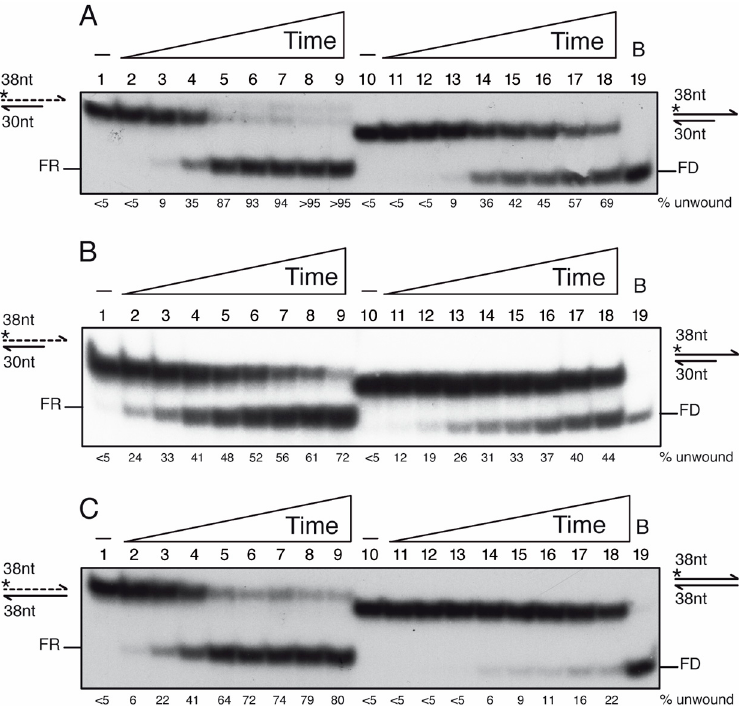
Figure 6. PcrA preferentially unwinds an RNA-DNA hybrid substrate. Helicase assays with [ γ 32 P]- 3 ′ -tailed duplex DNA or RNA-DNA hybrid ( A , B ), or duplex DNA or RNA-DNA hybrid ( C ) and a fixed PcrA concentration (100 nM) varying the incubation time (0.5, 1, 2.5, 5, 7.5, 10, 15 and 20 min, at 37 °C ( A , C ) or room temperature ( B ). Reactions were done in buffer D containing 2.5 mM ATP, and, after deproteinization, the substrate and products were separated by 15% PAGE in 0.5× TBE, and visualized by phosphor imaging. Abbreviations: -, the absence of PcrA protein; *, indicates the